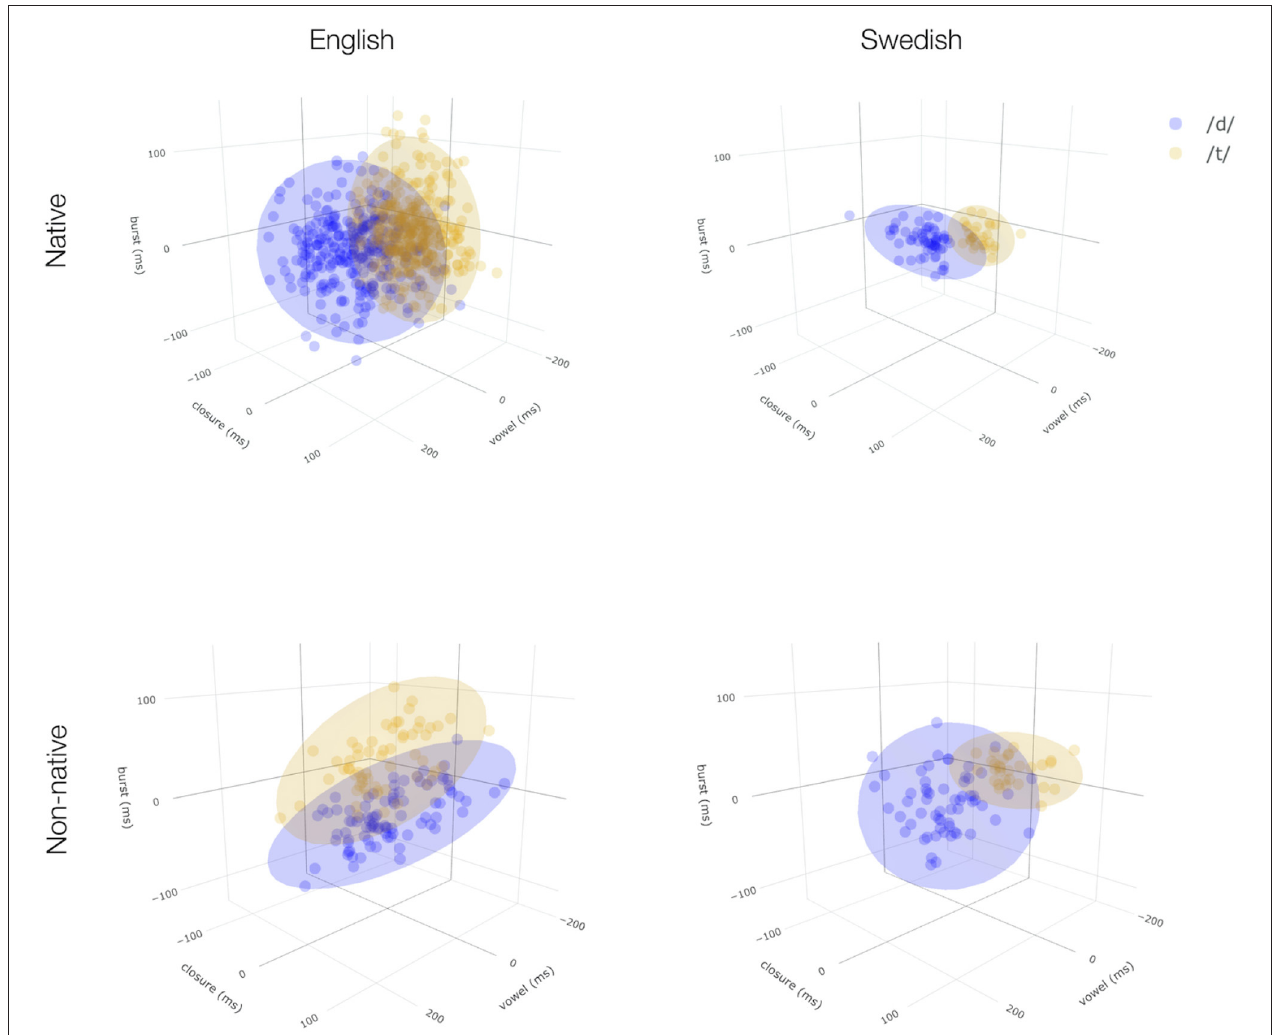
FIGURE 3 | Comparison of native- (top) and non-native-accented (bottom) syllable-final /d,t/ for both the English (left) and the Swedish (right) data. Productions combine information from multiple databases and are corrected for phonotactic context effects (see Supplementary Material , section 4.3) and are shown in the 3D space defined by three important cues (duration of vowel, closure, burst) to syllable-final voicing. Ellipses contain 95% of the probability mass centered around the mean under the assumption that categories form multivariate Gaussian distributions. To facilitate comparison, axis limits are held constant across panels. See Supplementary Material (section 4.3.2) for interactive visualization, 1D density plots, and 2D pair-wise correlation plots.